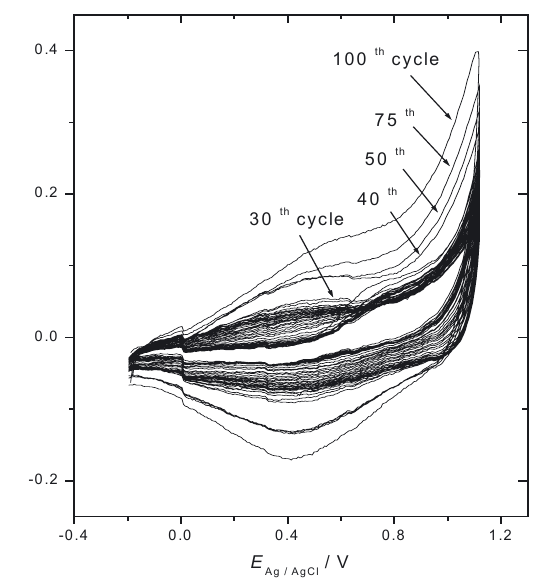
Figure 3. CVs (1,…, 30, 40, 50, 75, 100 th cycle) during formation of the poly(3MPy- β -DMCD) complex in a solution of 0.038 M (3MPy- β -DMCD) complex in acetonitrile + 0.05 M Li- < 1.10 V at a gold electrode, d E / ClO4, -0.20 < E Ag/AgCl d t = 50 mV·s -1 .